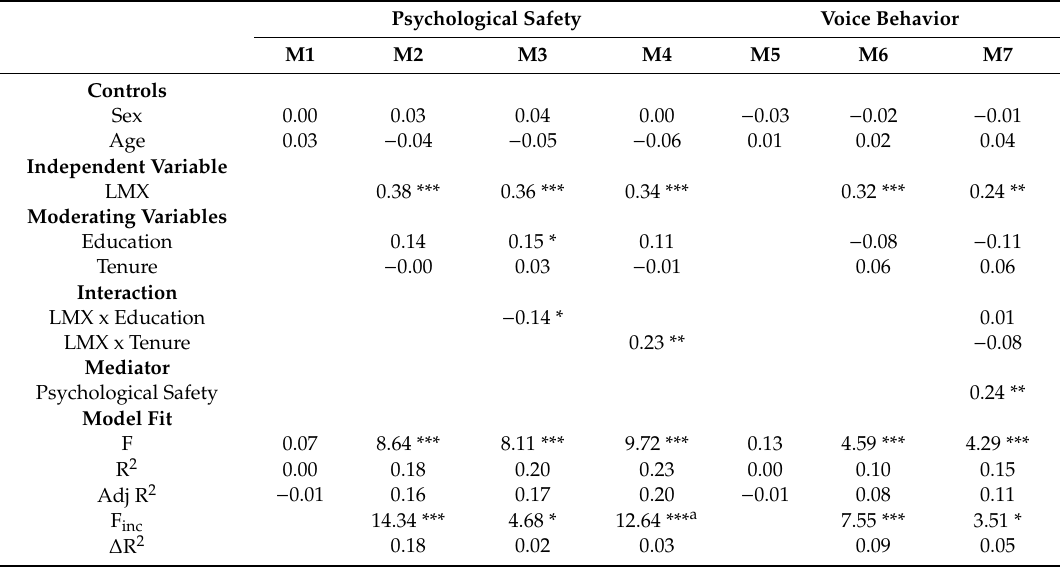
Table 3. Hierarchical multiple regression for psychological safety and voice